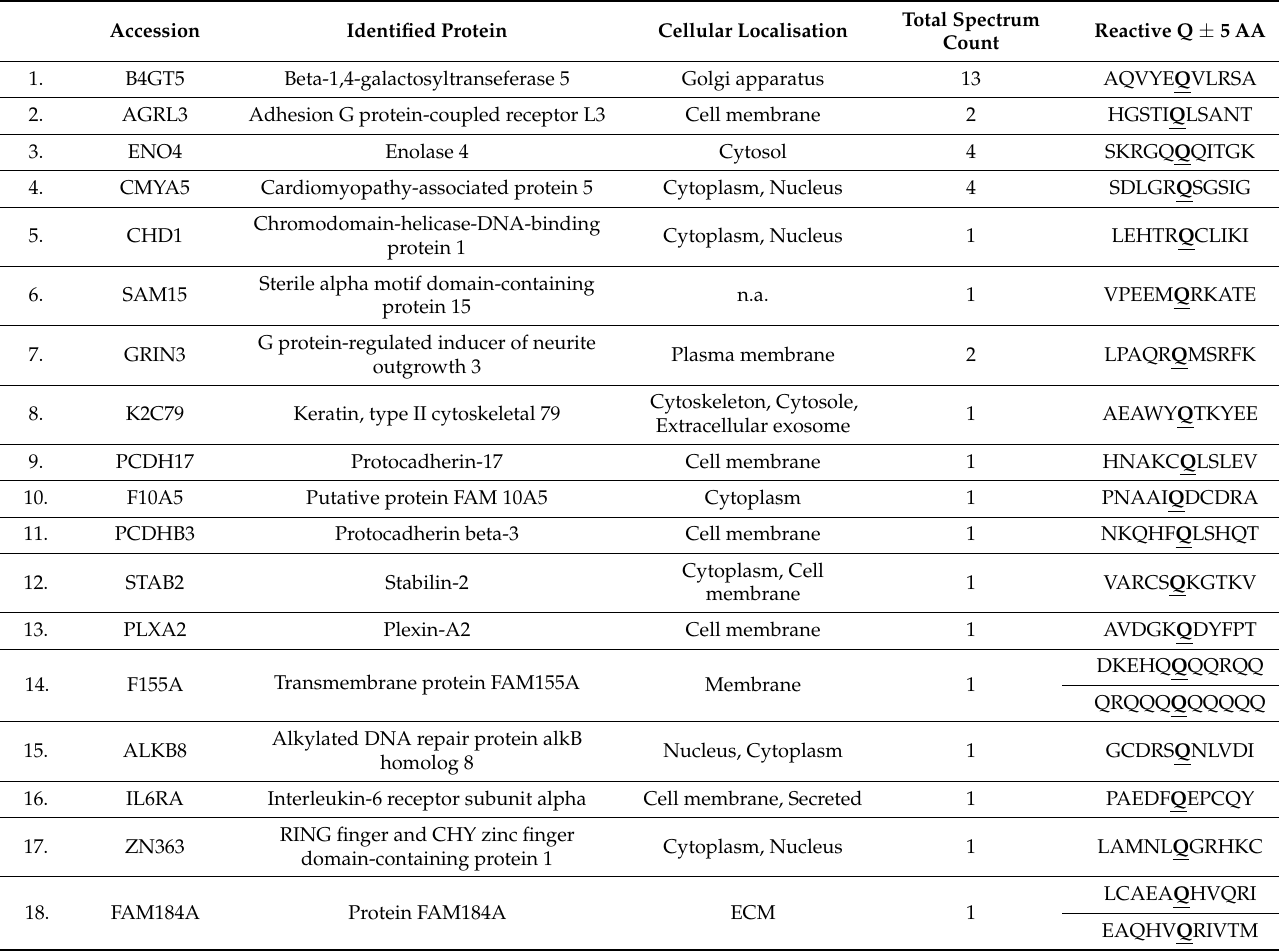
Table 3. Potential hTG4 substrate proteins containing BPA modified peptides detected with at least four consequent fragment ion series. Reactive glutamines are labelled by underlined and bold